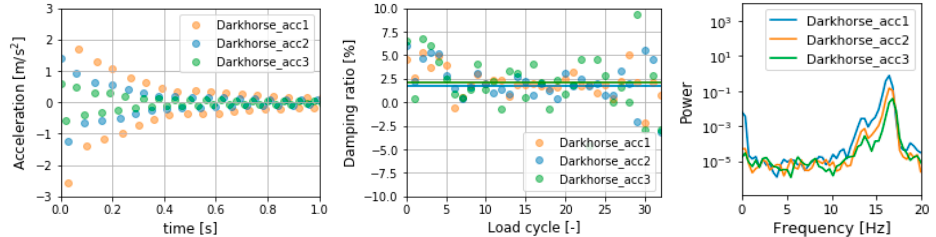
Figure 8. Results relative to tail decay test for the Darkhorse Board. ( left ) comparison of decay tests; ( center ) Damping ratio in each cycle; ( right ) Power Spectral Density and natural frequencies.